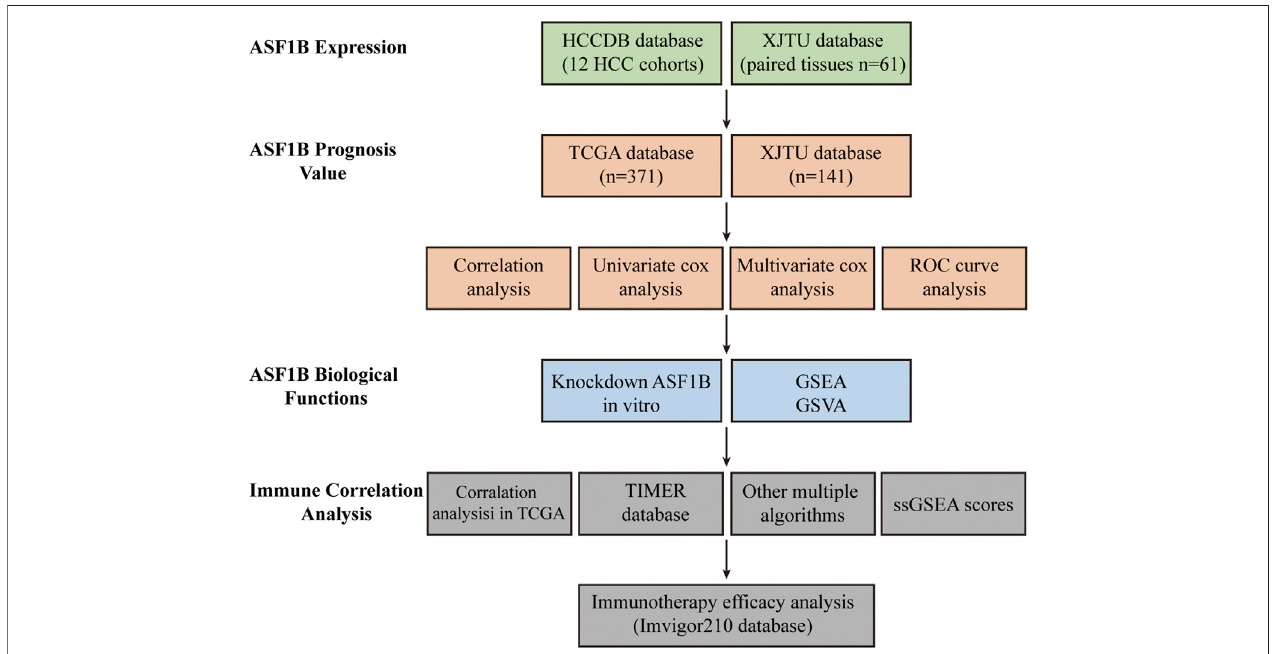
FIGURE 1 | Flow chart of the study